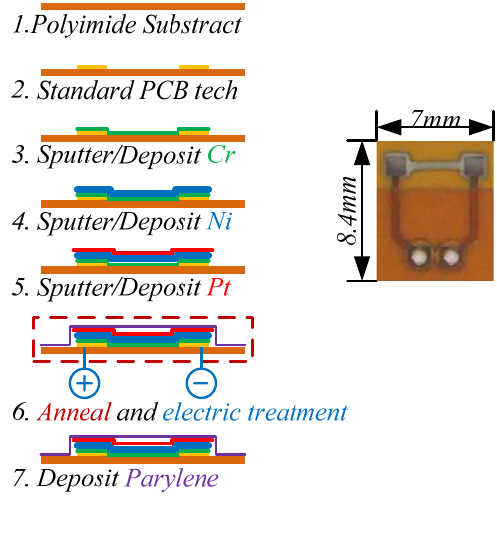
Figure 2. Diagram of the fabrication process of the hot film flow